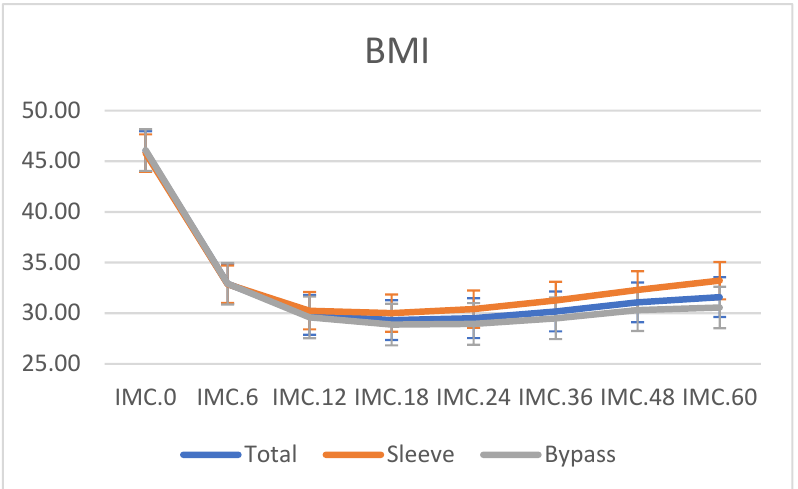
Figure 1. Evolution of body mass index (BMI) during the follow-up of RYGB and SG expressed in months.